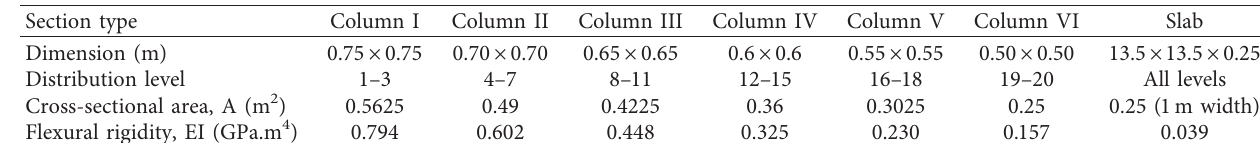
Figure 2: Designed sections of columns and slabs. Table 1: Summary of numerical simulations